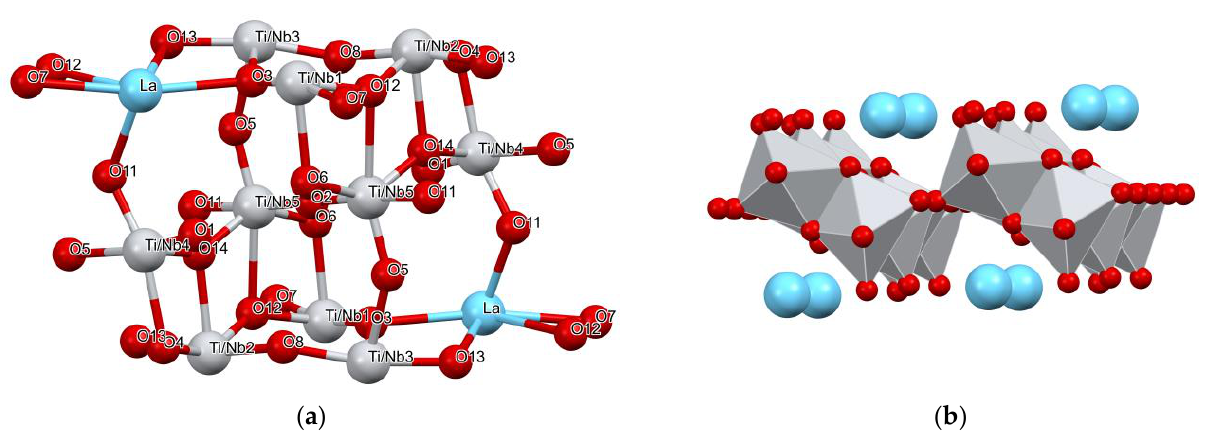
Figure 7. Layer of the second type (Ti/Nb4 and Ti/Nb5) embedded between layers of the first type (La, Ti/Nb1, Ti/Nb2 and Ti/Nb3): ( a ) Ball and stick model with atom labelling; ( b ) Polyhedral representation.